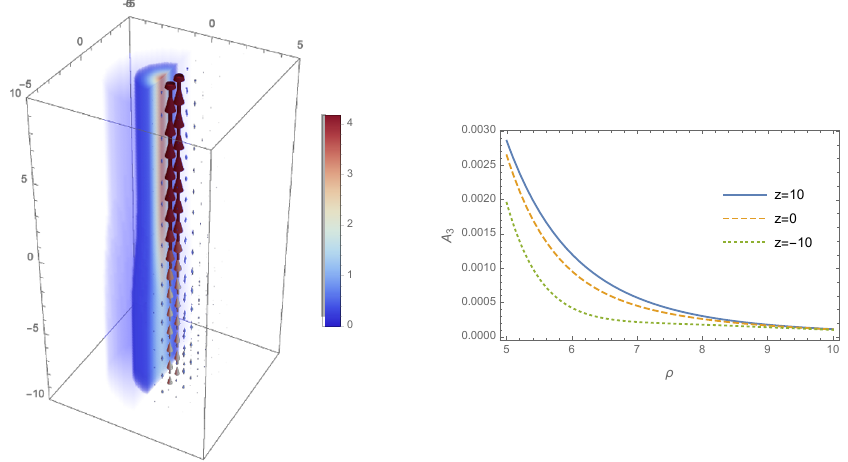
Figure 6 . Left panel: plot of the U(1) a topological current A i . The direction, color and size of the arrows are the same as those for the magnetic (cid:13)ux. Right panel: plot of A 3 versus (cid:26) at z = 10 ; 0 ; (cid:0) 10. In both the panels, we take the parameter choice (4.82) (tan (cid:12) = 3